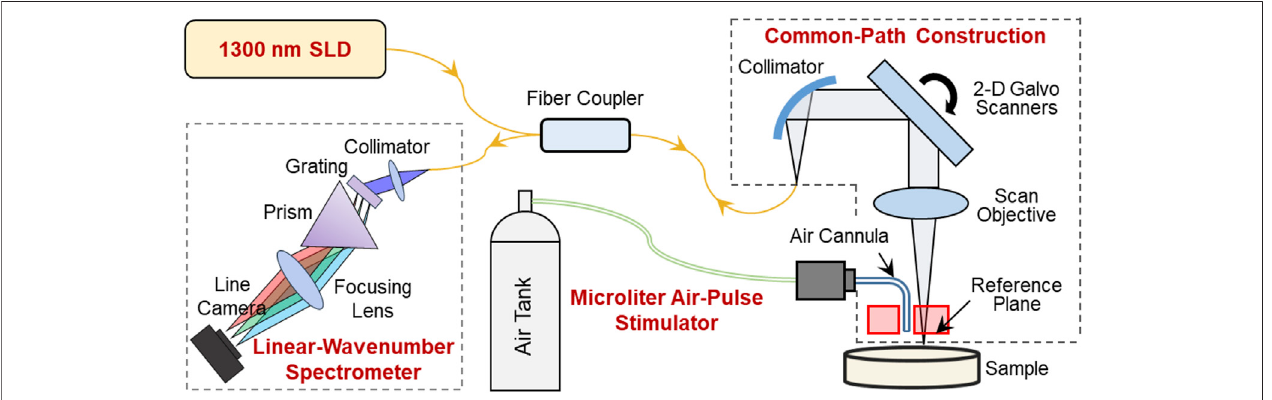
FIGURE1| Schematicoftheopticalcoherenceelastography(OCE)system.Amicroliterairpulsestimulatorwasusedtoevokesubmicron-scalemechanicalwaves in the sample, and a high-resolution phase-sensitive OCT imaging system was used to track and record the tissue response dynamics. In the OCE imaging subsystem, SLDisasuperluminescentlaserdiodewithawaveband of1,290±40 nm;thesampleandreferencearmsshareacommonopticalpathtoenhancethephasedetection stability; and a linear-wavenumber spectrometer was used to disperse the interference spectrum optically in the wavenumber domain to enhance imaging detection